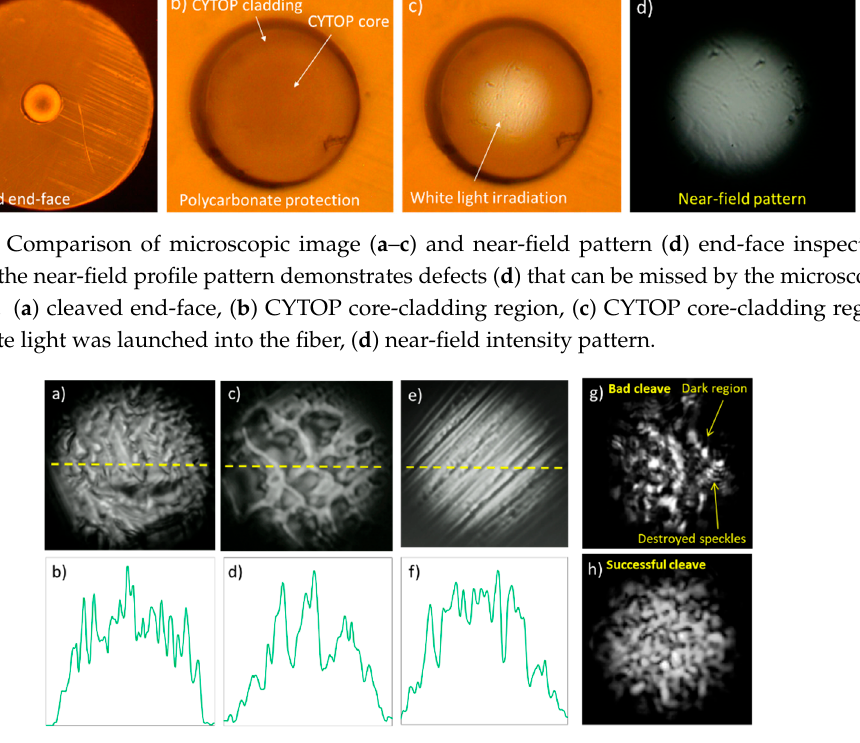
Figure 4. Three examples of poor-quality cleaves of the CYTOP fiber: near-field patterns, ( a , c , e ) and intensity profiles, ( b , d , f ) generated by incoherent fiber launch. The dashed line indicates the location of the near-field profile at the near-field pattern. Comparison of speckle patterns formed at poor ( g ) and successful ( h ) cleaved end-faces when the fiber was launched using a coherent source.